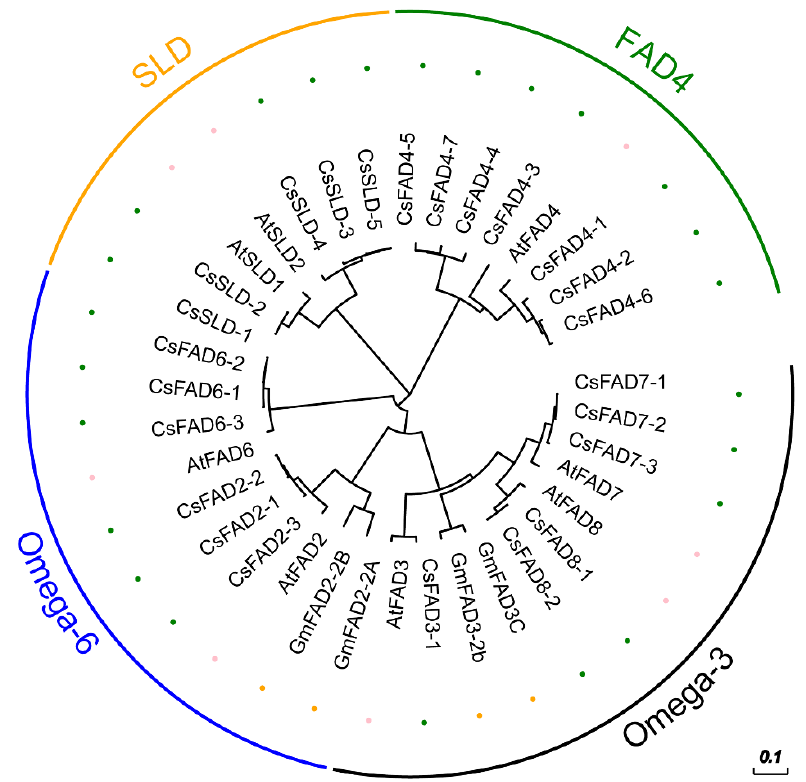
Figure 1. Phylogenetic analysis of FAD proteins in Camelina sativa, Arabidopsis thaliana, and Glycine max. Neighbor-joining phylogeny of 36 FAD genes in the 3 species was analyzed by using MEGA 7.0 with 2000 times bootstrap replications. Tree scale is 0.1. FAD family was divided into four subfamilies, namely Omega-3, Omega-6, FAD4, and SLD, which are labeled in the outermost layer. Three different colors were selected to represent three species.